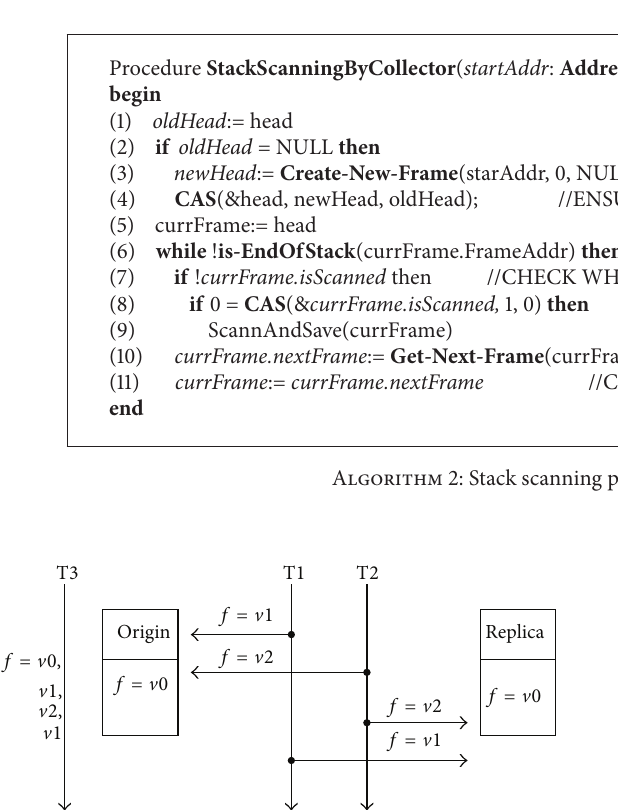
Figure 2: An example of inconsistency scenario during the copying